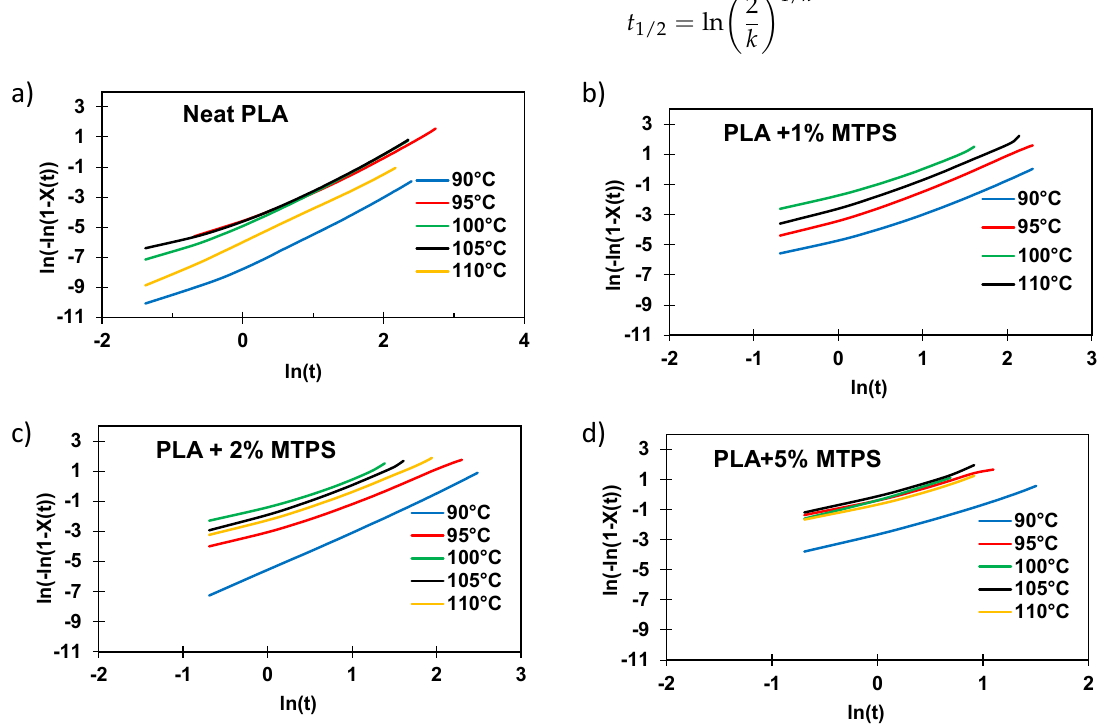
Figure 12. Plots of ln (ln(1-X(t)) vs. ln t of ( a )PLA and blends ( b ) PLA+1%MTPS, ( c ) PLA + 2%MTPS, ( d ) PLA + 5% MTPS at various temperatures.